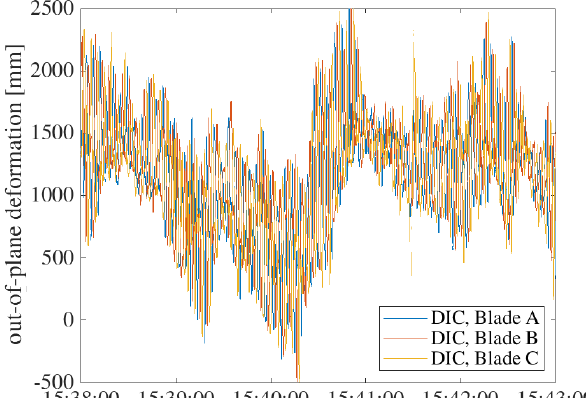
Figure 14. OoP DIC signal of all blades.